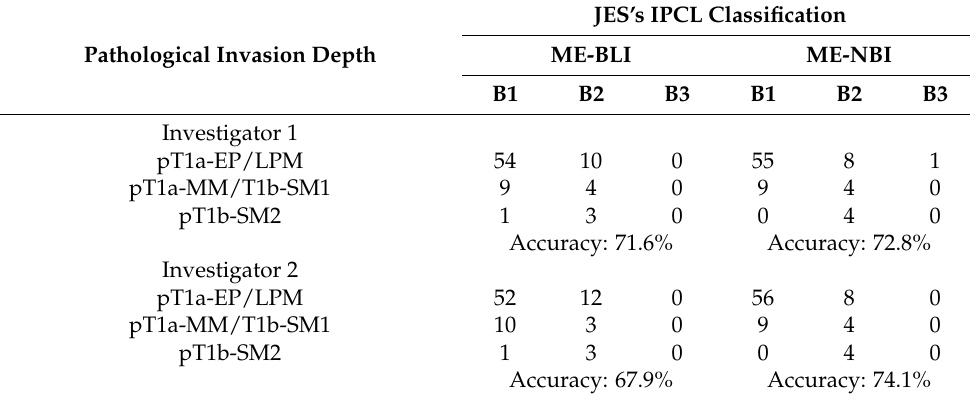
Table 2. The relationship between the JES’s IPCL classification and pathological invasion depth in ME-BLI and